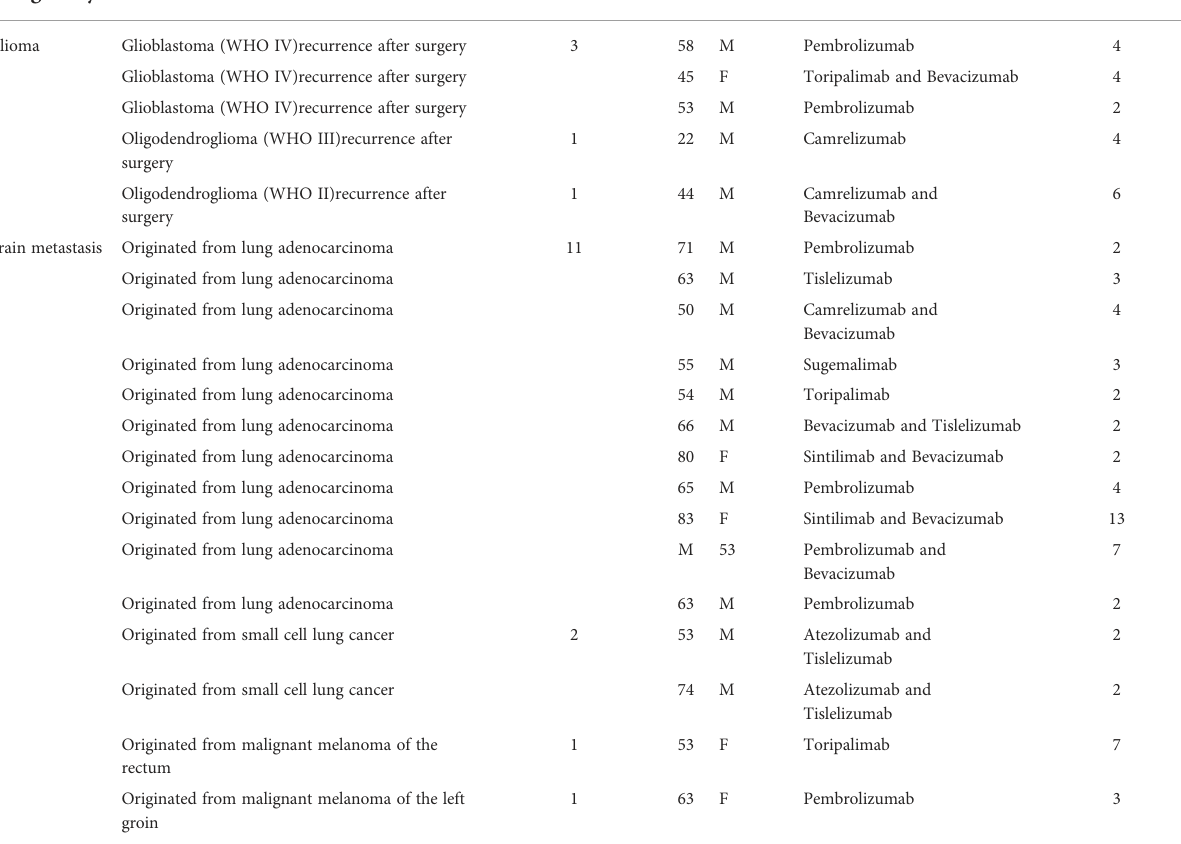
TABLE 3 Detailed information of